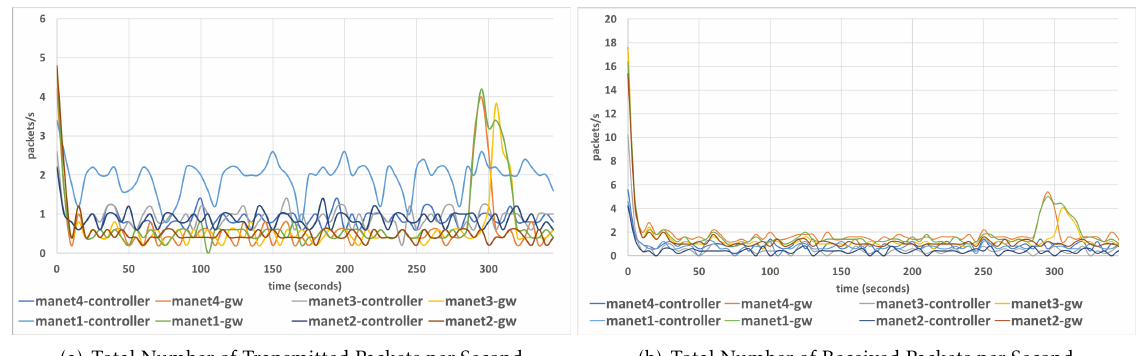
Figure 9. Deployment of a Mid-Tier Network